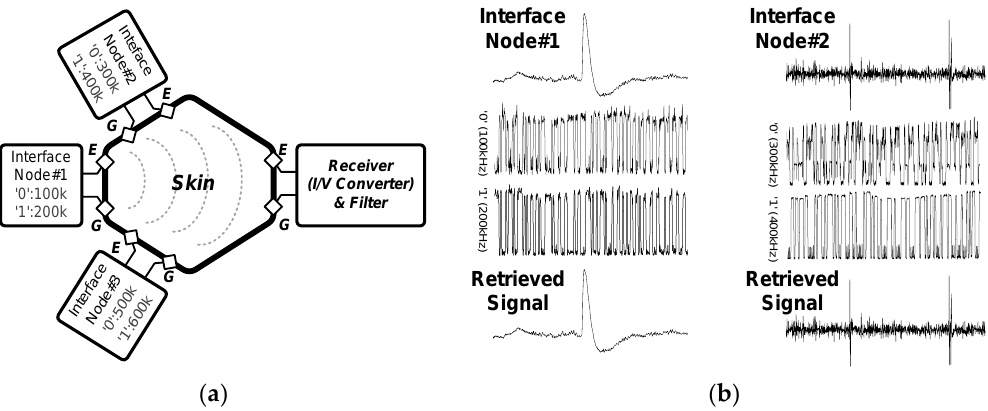
Figure 20. Intra-skin communication (ISCOM) characterization: ( a ) measurement diagram and ( b ) two channel data transmission.